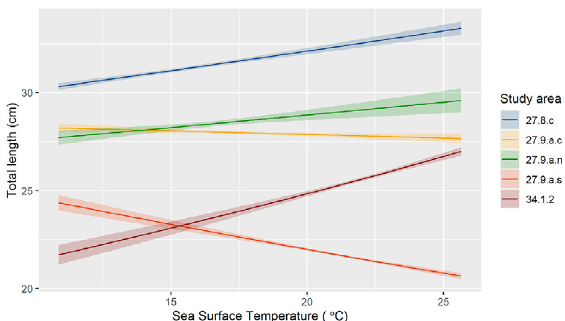
Fig. 6. – Predicted effect of sea surface temperature on total length in each study area. Geographical study areas from south to north are 34.1.2, Canary Islands; 27.9.a.s, Gulf of Cadiz; 27.9.a.c, W Portuguese coast; 27.9.a.n, NW Spanish coast; 27.8.c., Cantabrian Sea. Shaded area, 95% confidence